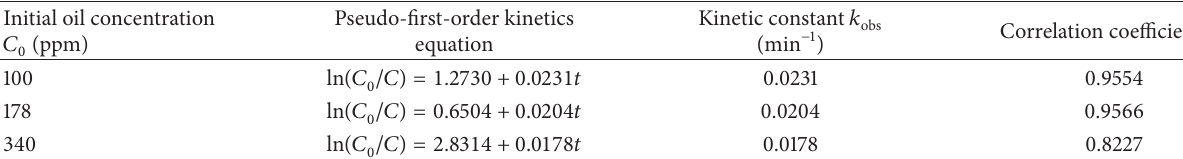
Table 1: Kinetic parameter of oil degradation.